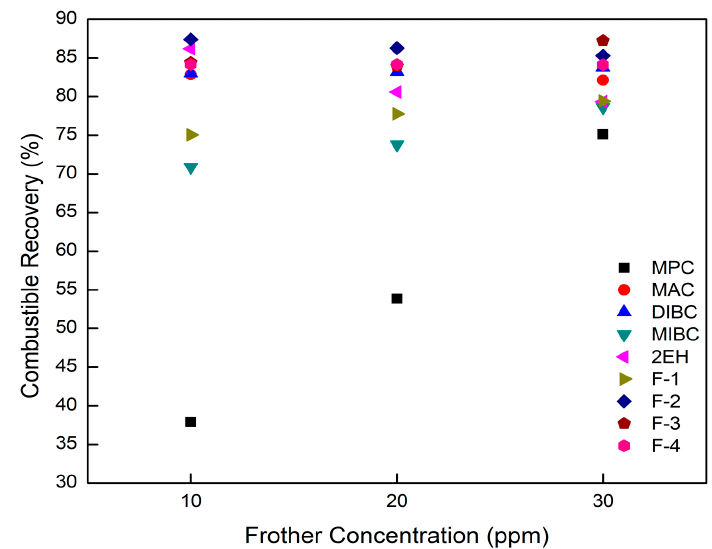
Figure 7. Combustible recovery values obtained as a function of frother concentration for each frother type.